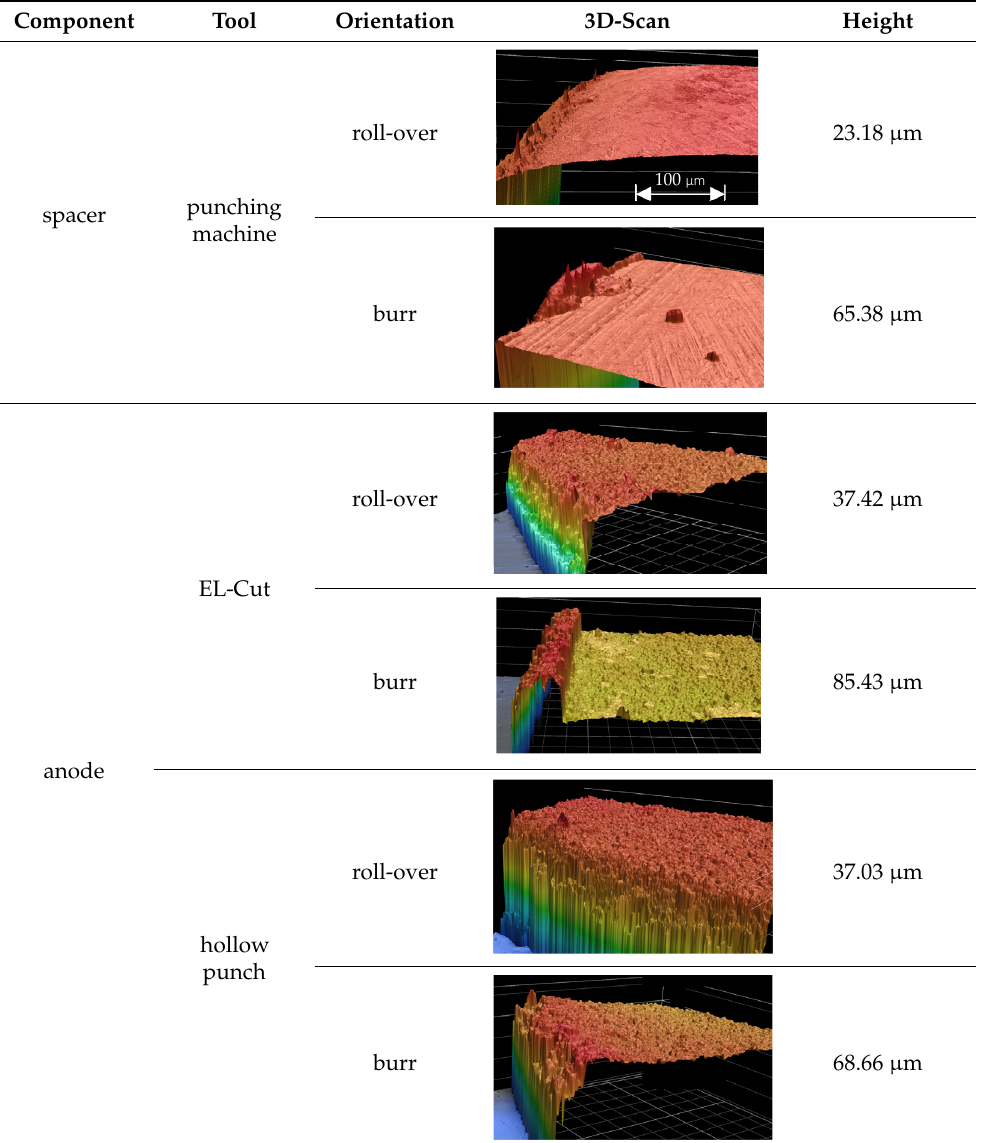
Table 4. Tool suitability for punching separators and electrodes .